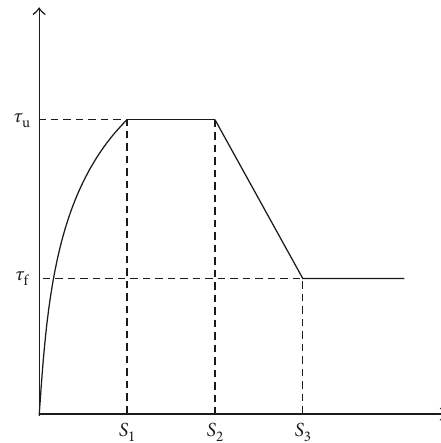
Figure 3: Constitutive relations of steel bars.